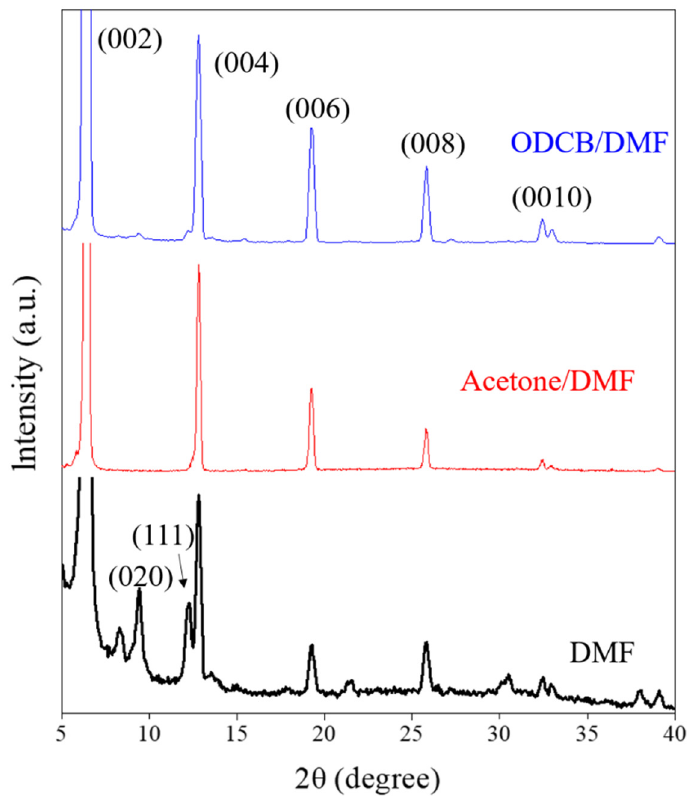
Figure 3. XRD pattern of 2D perovskite growth on a glass substrate achieved by a single solvent (DMF), acetone/DMF co-solvent, and ODCB/DMF co-solvent solution processing step.